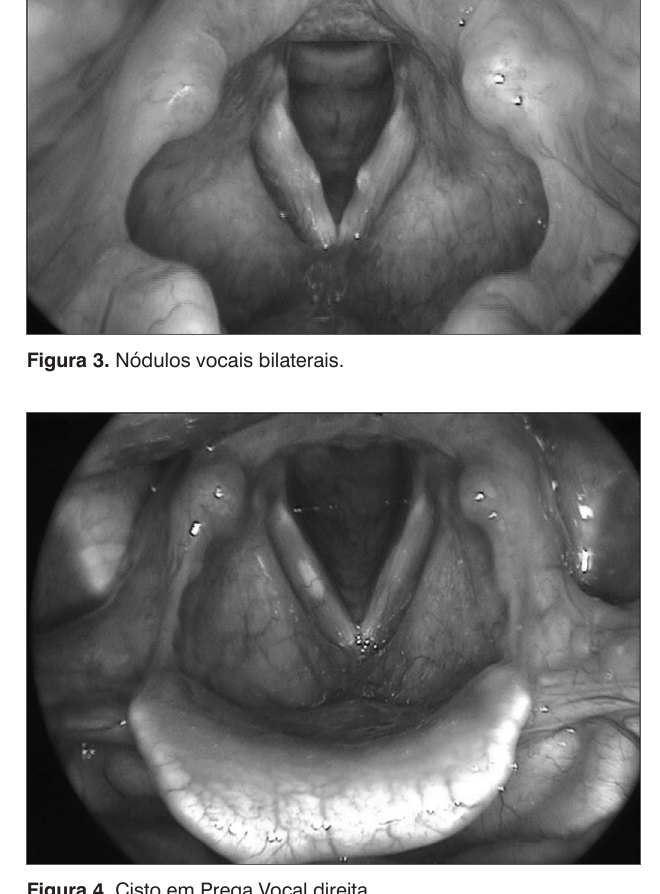
Figura 4. Cisto em Prega Vocal